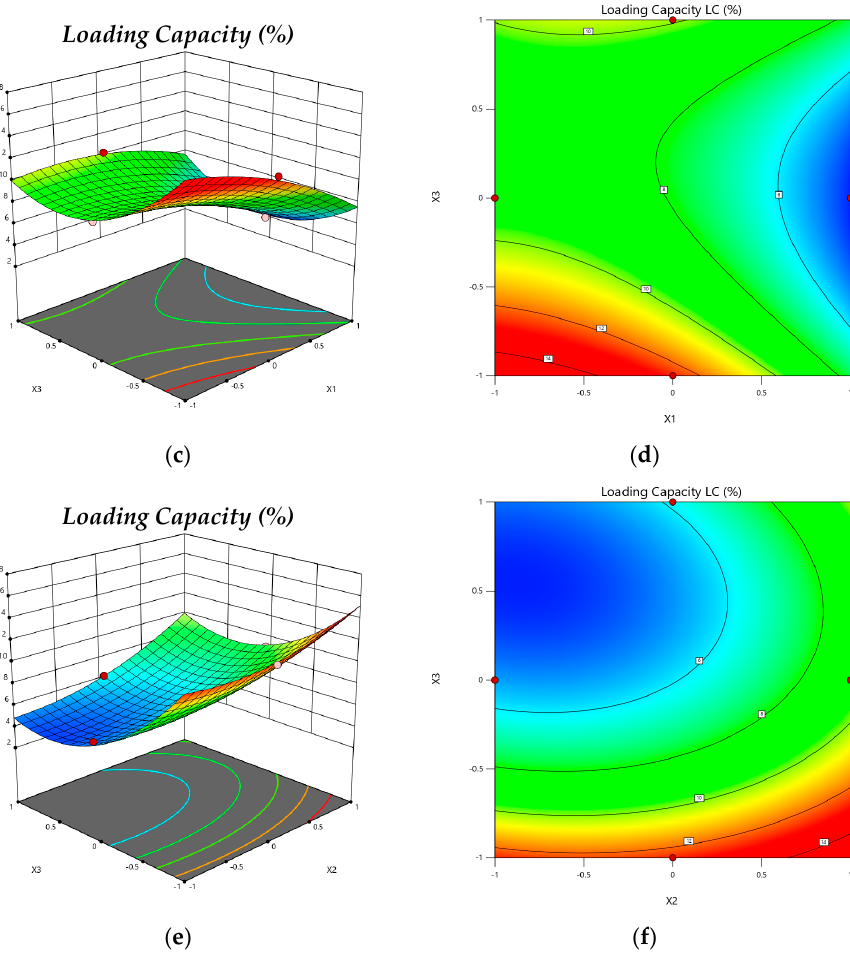
Figure 3. Model graphs: Loading Capacity. ( a ) Three-dimensional response surface plots showing the effect of variables (X 1 = pH (4.4) and X 2 = Chitosan: Chincho essential Oil ( w / v ) (1:0.7)) on response (Loading Capacity), ( b ) 2D contour graph, ( c ) 3D response surface plots showing the effect of variables (X 1 = pH (4.4) and X 3 = Chitosan: TPP ( w / w ) (1:0.46)) on the response (Loading Capacity), ( d ) 2D contour graph, ( e ) 3D response surface plots showing the effect of variables (X 2 = Chitosan: TPP ( w / w ) (1: 0.7) and X 3 = Chitosan: TPP ( w / w ) (1:0.46)) on response (Loading Capacity) and ( f ) 2D contour graph.